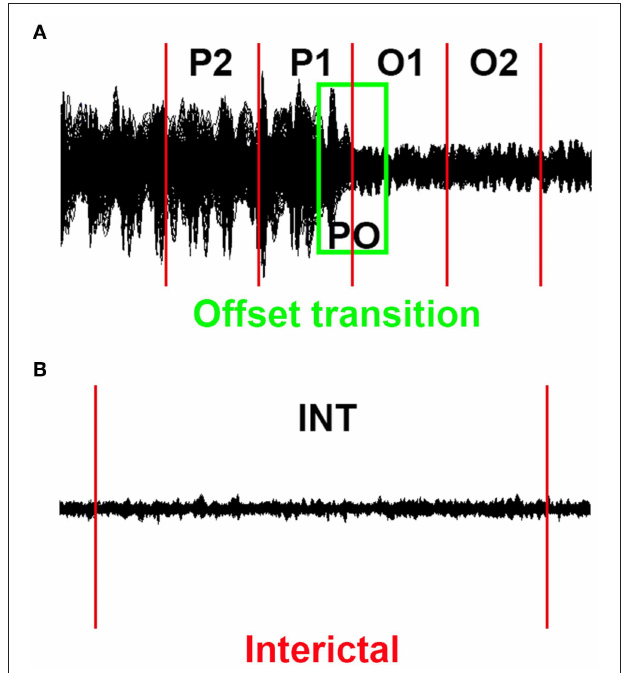
FIGURE 1 | Schematic of MEG waveforms. Five 1s offset transition epochs (P2, P1, PO, O1, and O2) for each epileptic activity (A) and the corresponding 100s interictal epochs (B) were